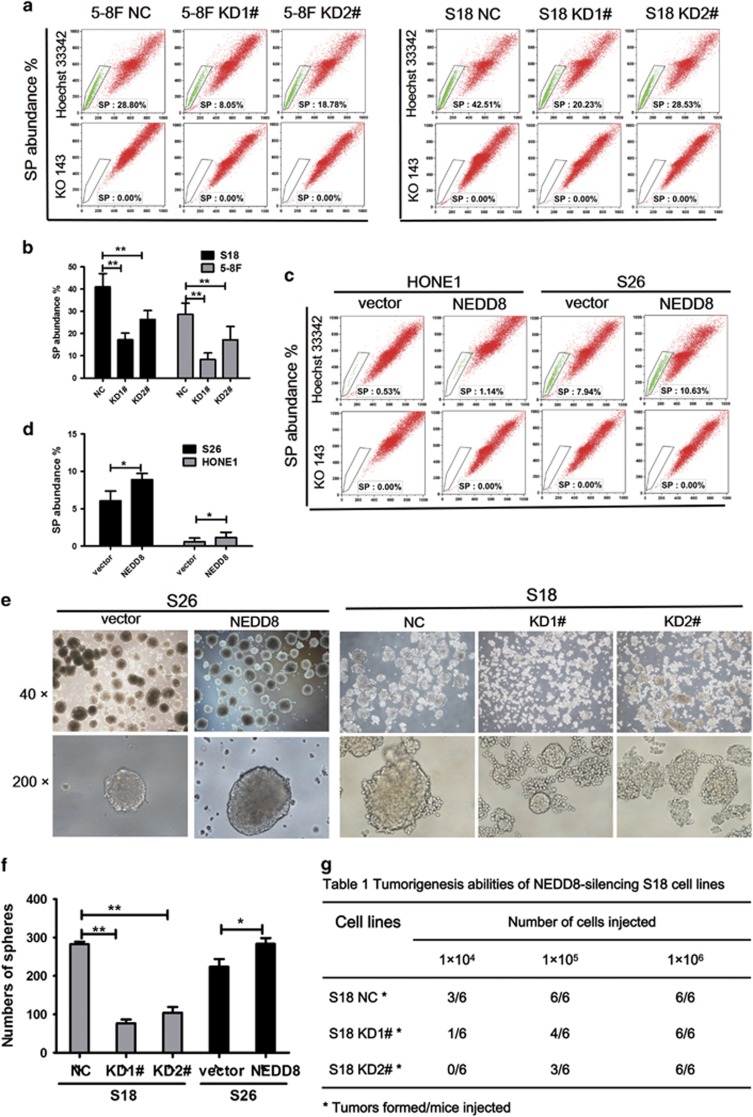
NEDD8 suppresses the stemness of NPC cells in vitro and the tumorigenicity in vivo. (a,c) The side population (SP) cells assay. S18 and 5-8 F cells with knockdown NEDD8, S26 and HONE1 with overexpression NEDD8 were treated with 5 μM ko143 and 5 μg/ml Hoechst 33342 dye and tested by flow cytometric analysis. (b,d) Representative flow cytometric histograms demonstrated a distinct percentages of SP cells. (e,f) The images (up panel) and quantifcation of the number of spheres (down panel) formed from the indicated stable cell lines in DMEM/F12 medium with the addition of EGF and FGF for 7–8 days. (g) Tumorigenesis abilities: NEDD8-silencing S18 cells in three cell concentrations injected to nude mice and observed for 20 days. The results are presented as the means±S.E.M., and three independent experiments were performed. *P<0.05, **P< 0.01